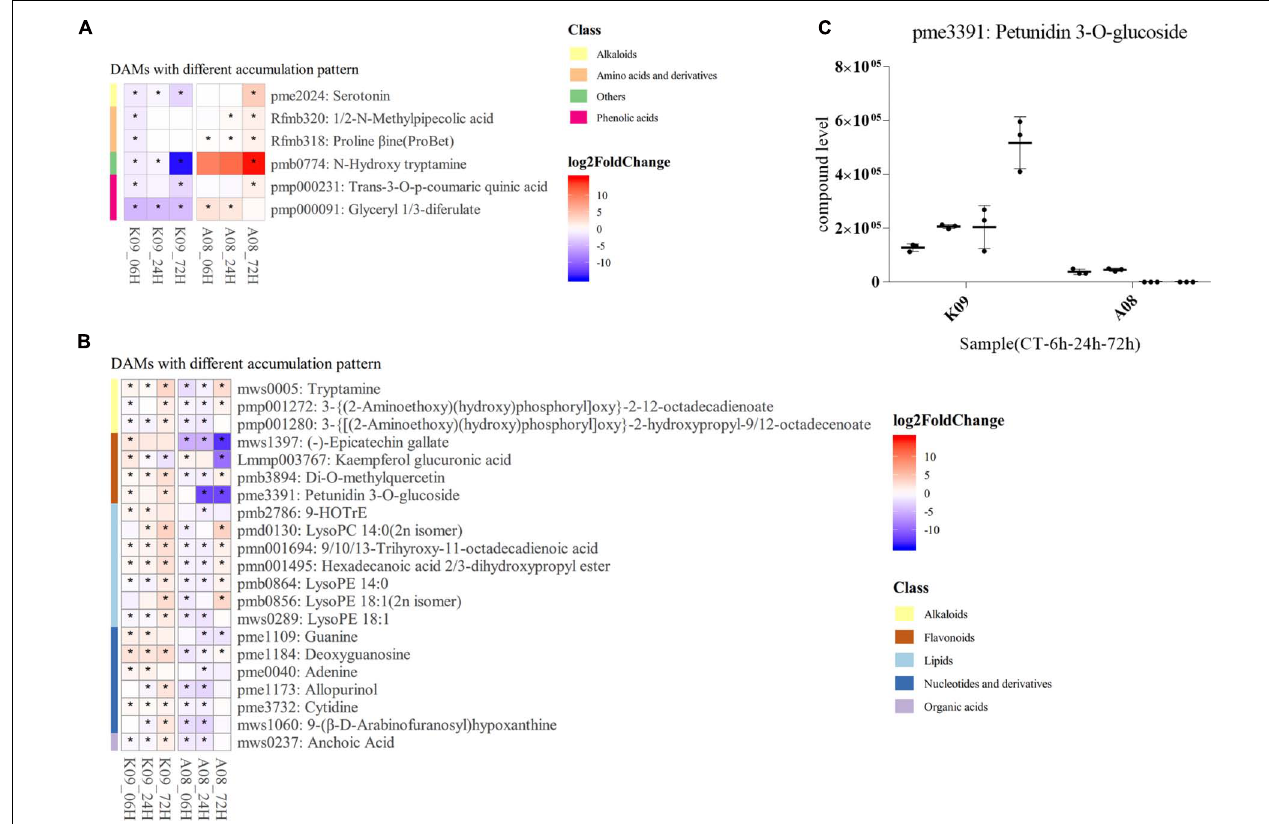
FIGURE 10 | Identification of significantly discriminative metabolites between K09 and A08 upon infection with F. graminearum . (A) DAMs up-regulated in K09, but down-regulated in A08. (B) DAMs down-regulated in K09 but up-regulated in A08. (C) The quantitative comparison of petunidin 3- O -glucoside (pme3391) contents in the stems of K09 and A08 at different time points upon infection with F. graminearum . The side bars with different color on the left of heatmap of (A) and (B) represent different classes of metabolites shown on the right. The different colors in the heatmap represent log2 fold change of each metabolite at different time points between two lines labeled on the bottom of the map, and stars indicate the statistical significance by two-way ANOVA ( p ≤